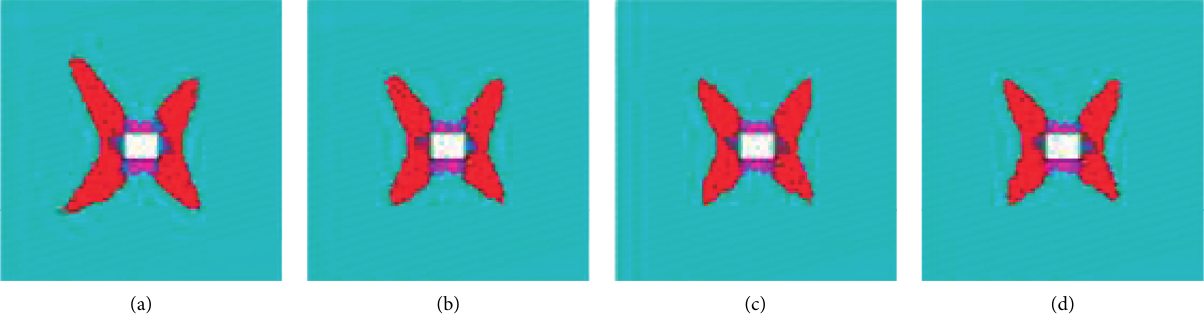
Figure 14: Morphology of plastic zone under different normal stiffness of bedding surface. (a) 5 e 9 MPa · cm − 1 . (b) 10 e 9MPa · cm − 1 .